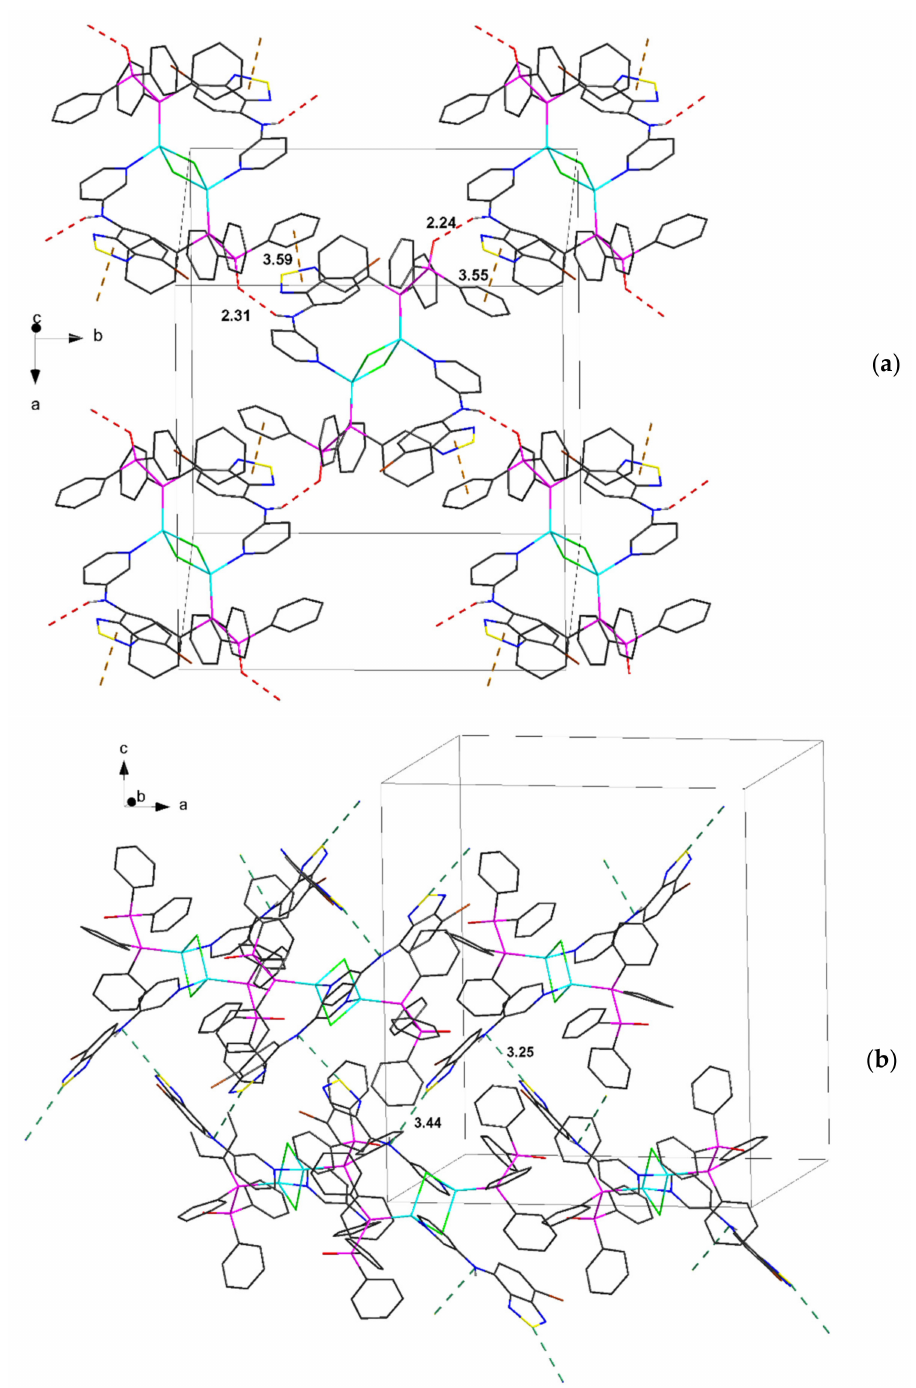
Figure 3. Crystal packing of 3 · 2C 7 H 8 showing ( a ) π – π interactions (orange dashed lines) and N 4 H ··· O hydrogen bonds (red dashed lines) and ( b ) S ··· N 4 contacts (green dashed lines). Toluene molecules and hydrogens except those participating in the hydrogen bonds are not